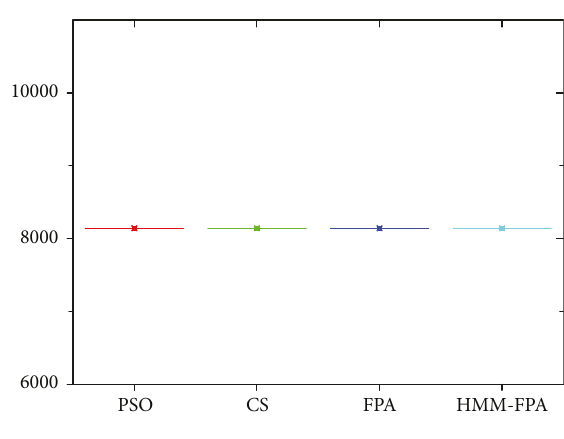
Figure 4: ANOVA tests of Car1.